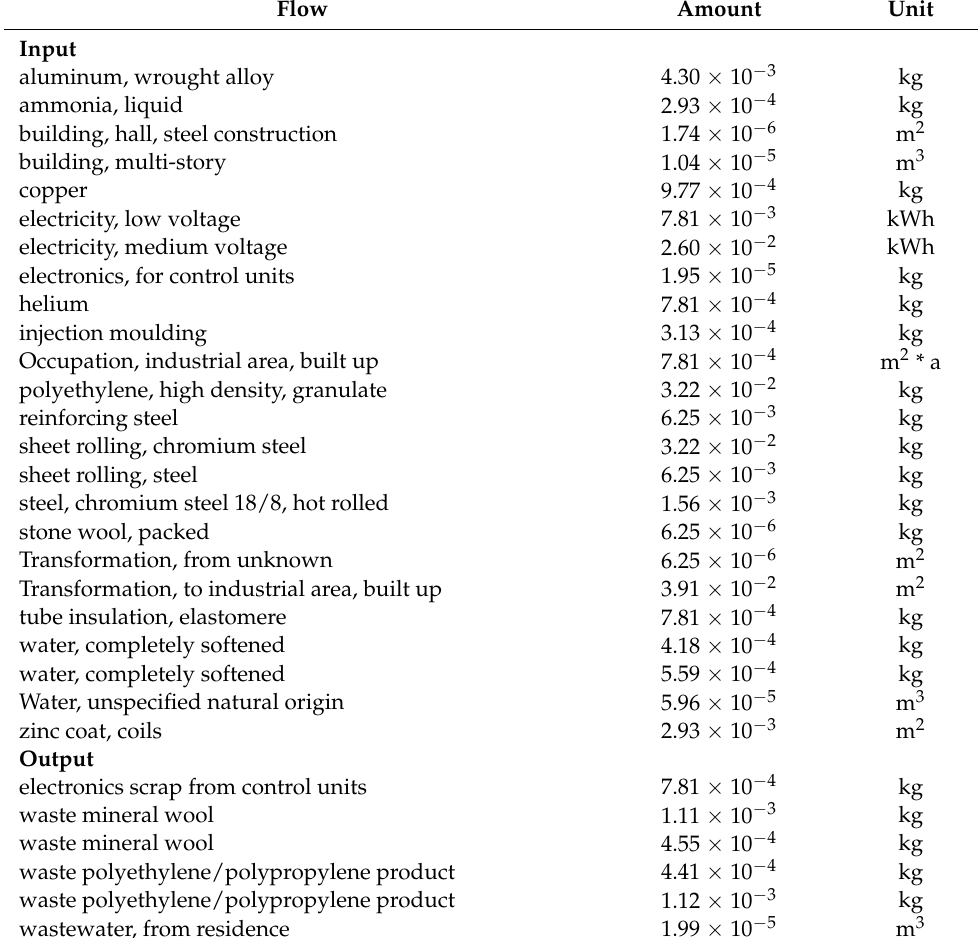
Table A3. Material inventory data for thermal effluent heat source AHP (Case 1).